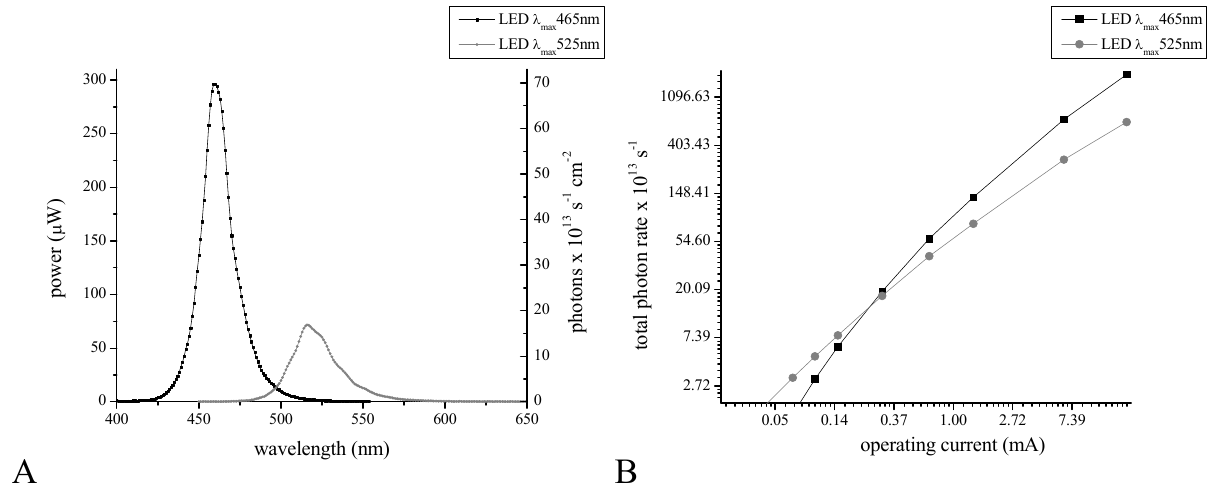
Figure 8. Spectral characteristics of LEDs: The spectral characteristics of the blue-emitting LED λ = 465 nm and the green emitting LED λ max operating current of 18.5 mA ( A ). Operating current versus photon emission rate is displayed in ( B